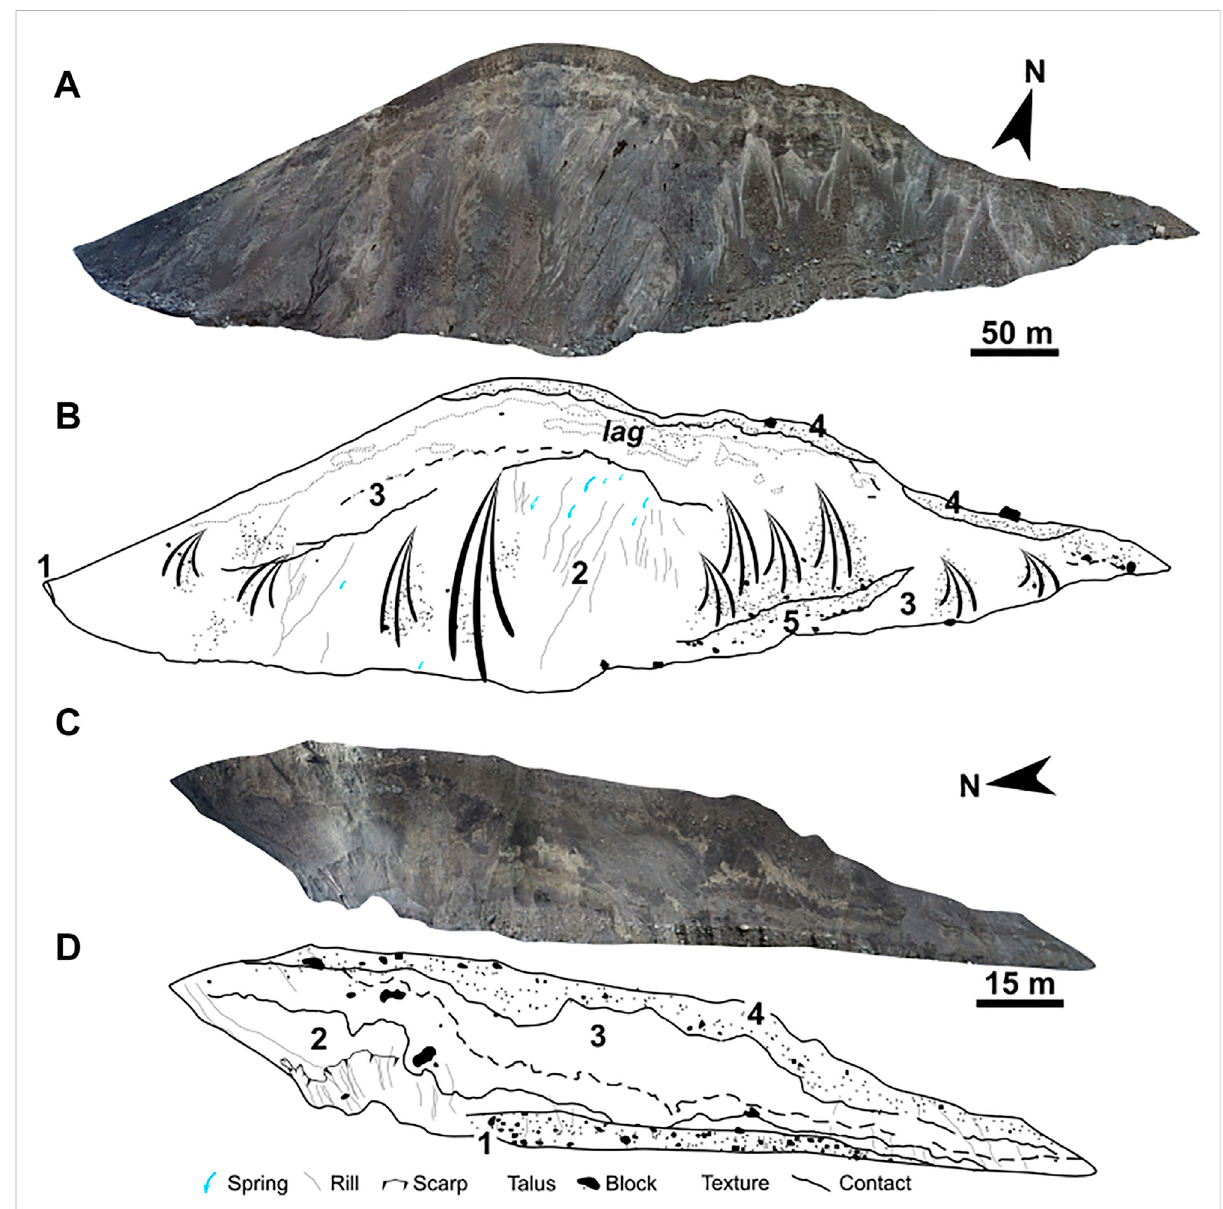
FIGURE 4 UAV photogrammetric models (captured in April 2021) and digitised dam face maps of the true right of the Spillway (A) and (B) (representing a lateralcross-sectionofthedam)andtrueleftoftheGut (C) and (D) (representingalongitudinalcross-sectionofthedam).Rillsincludesmallgulliesin deposit and talus, and scarps indicate secondary movement of dam debris. Texture includes fl ame structures, internal shears, etc. Numbers correspond to facies described in text and Figure